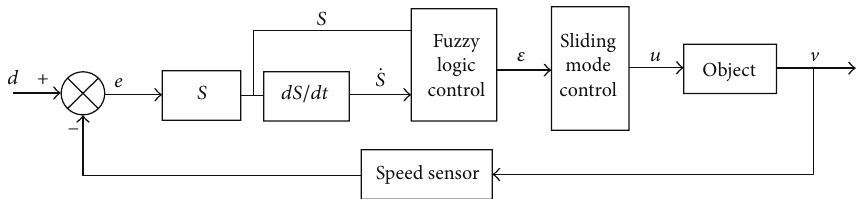
Figure 8: Sliding mode based on fuzzy reaching law control